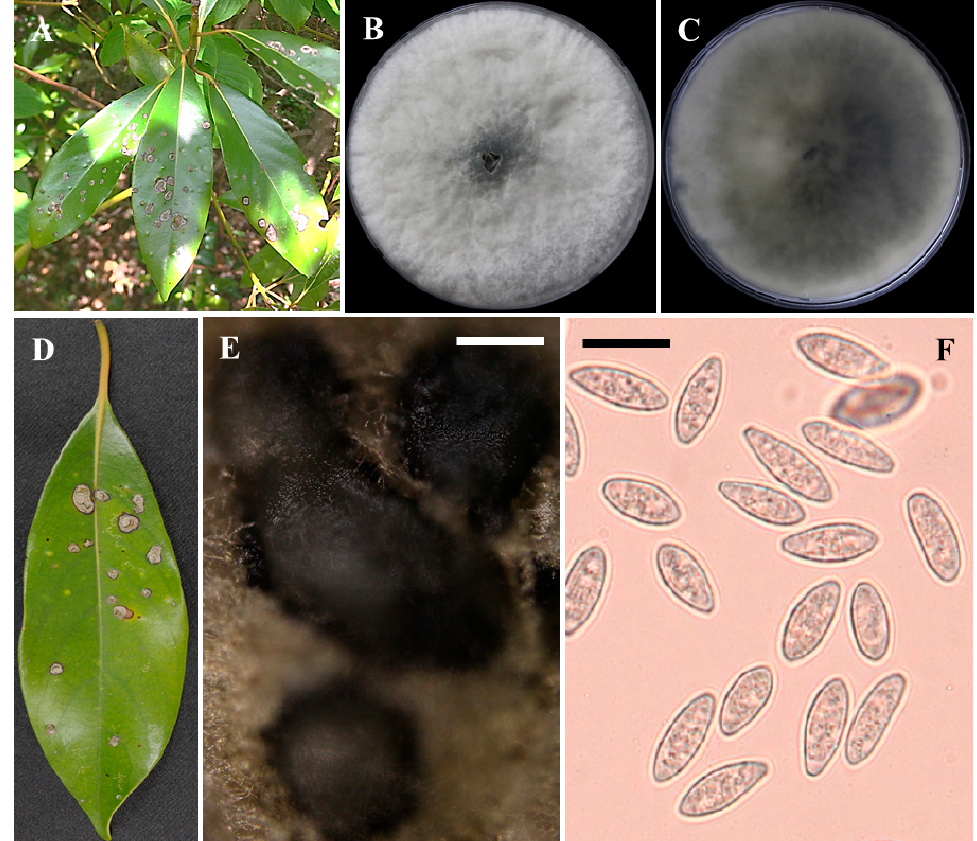
Figure 1. The symptoms of leaves of Japanese bay tree and the morphology of Neofusicoccum parvum . Symptoms occurring naturally on leaves of Machilus thunbergii on Wando Island, Korea during May to June 2020 ( A , D ). Obverse and reverse colony morphology on PDA at 25 ◦ C for 7 days ( B , C ). Pycnidia and conidia induced to form under 14 h–10 h light dark conditions ( E , F ). Scale bars E = 100 μ m and F = 25 μ m.